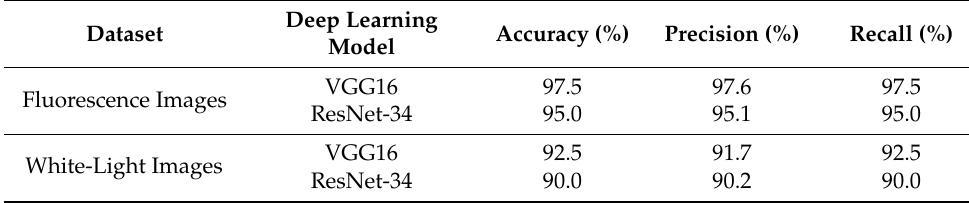
Table 3. RGB-image-based Training Table 3. RGB ‐ image ‐ based Training results.